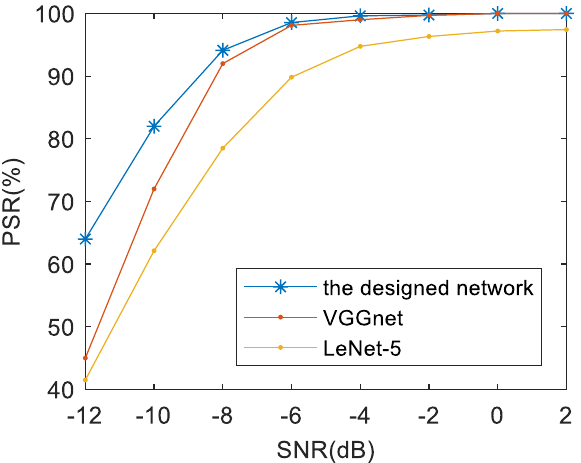
Figure 13. The effects of different networks on the PSR of the proposed approach.